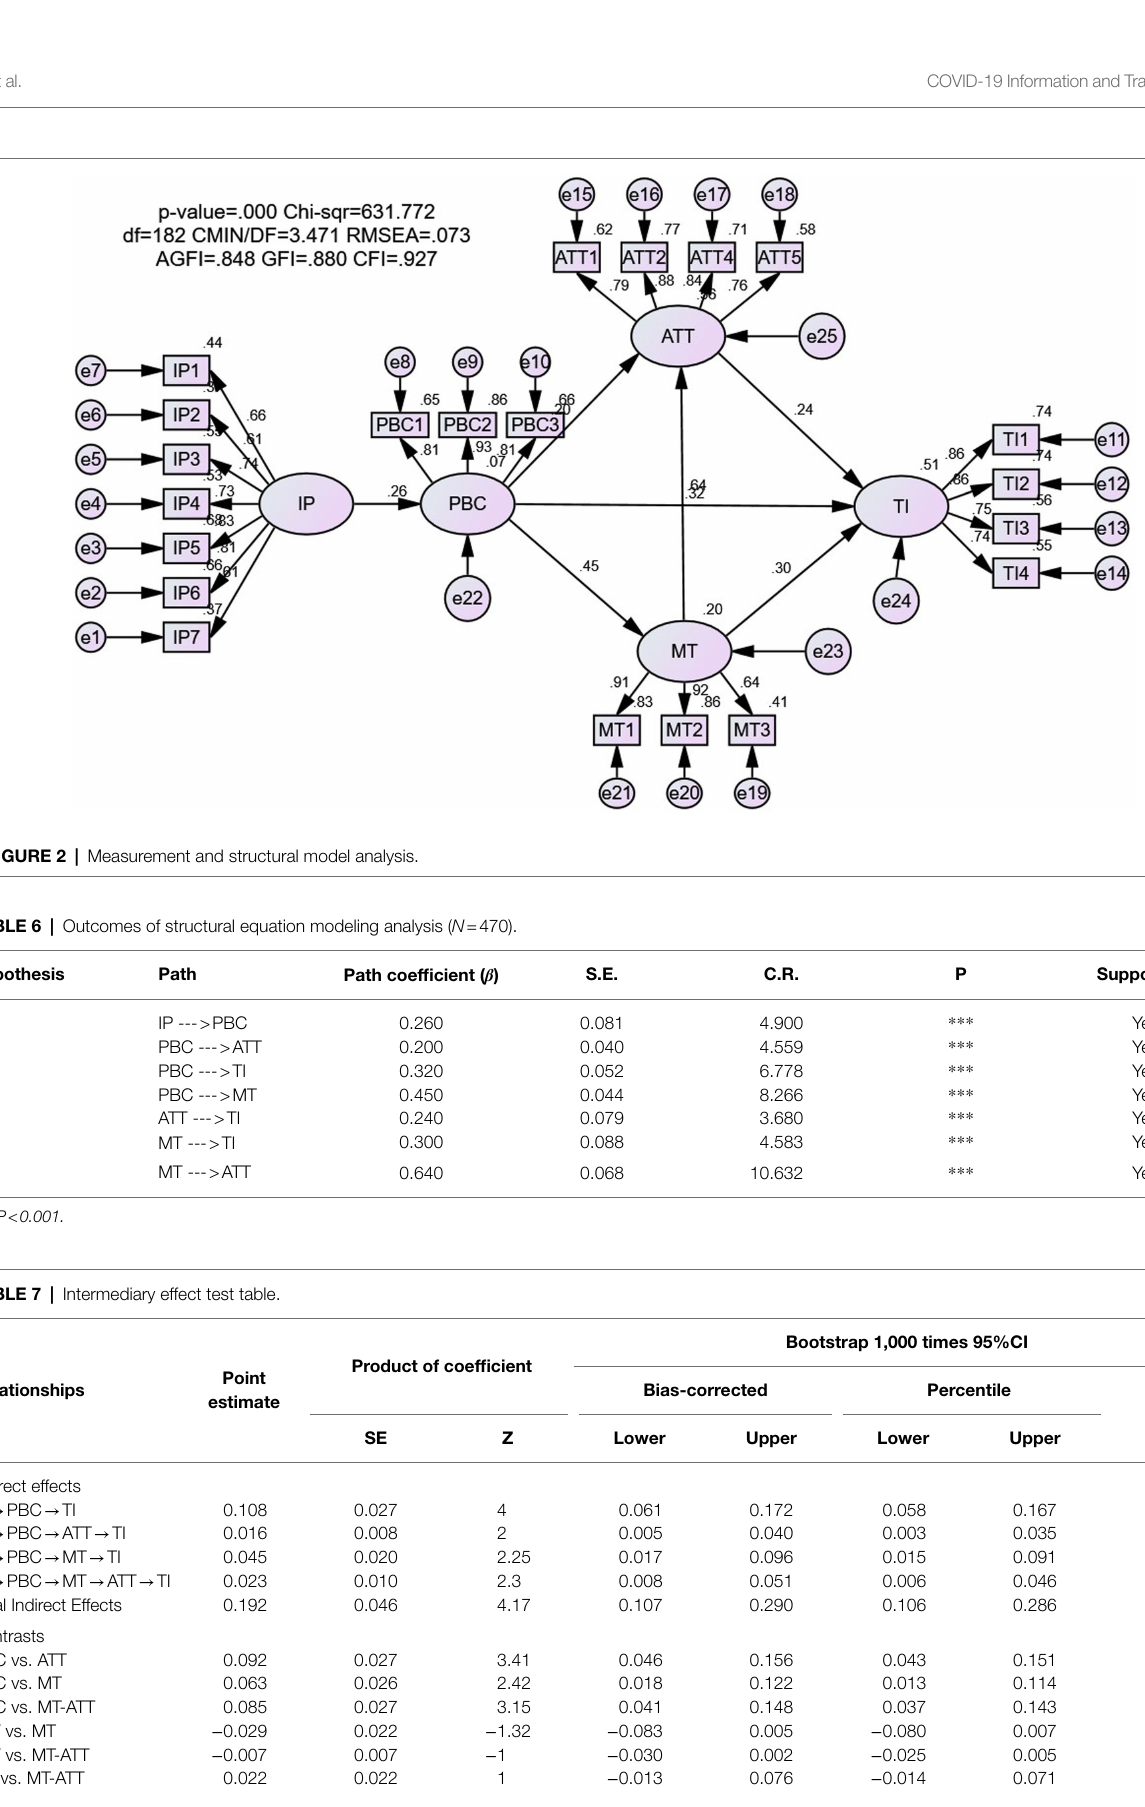
Contrasts PBC vs.